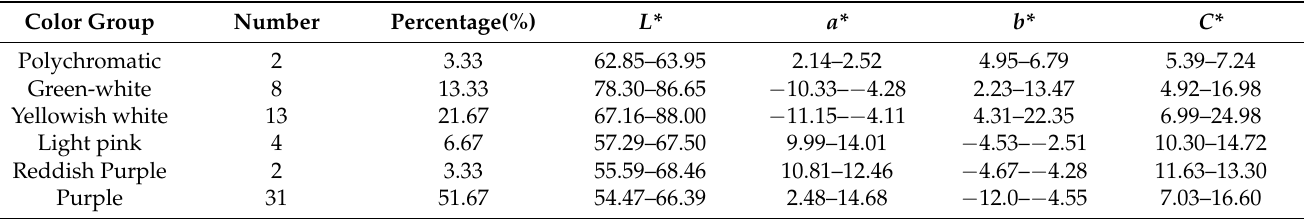
Table 6. The distribution range of flower color— L* , a* and b* parameters of each color group in L. chinense var. rubrum